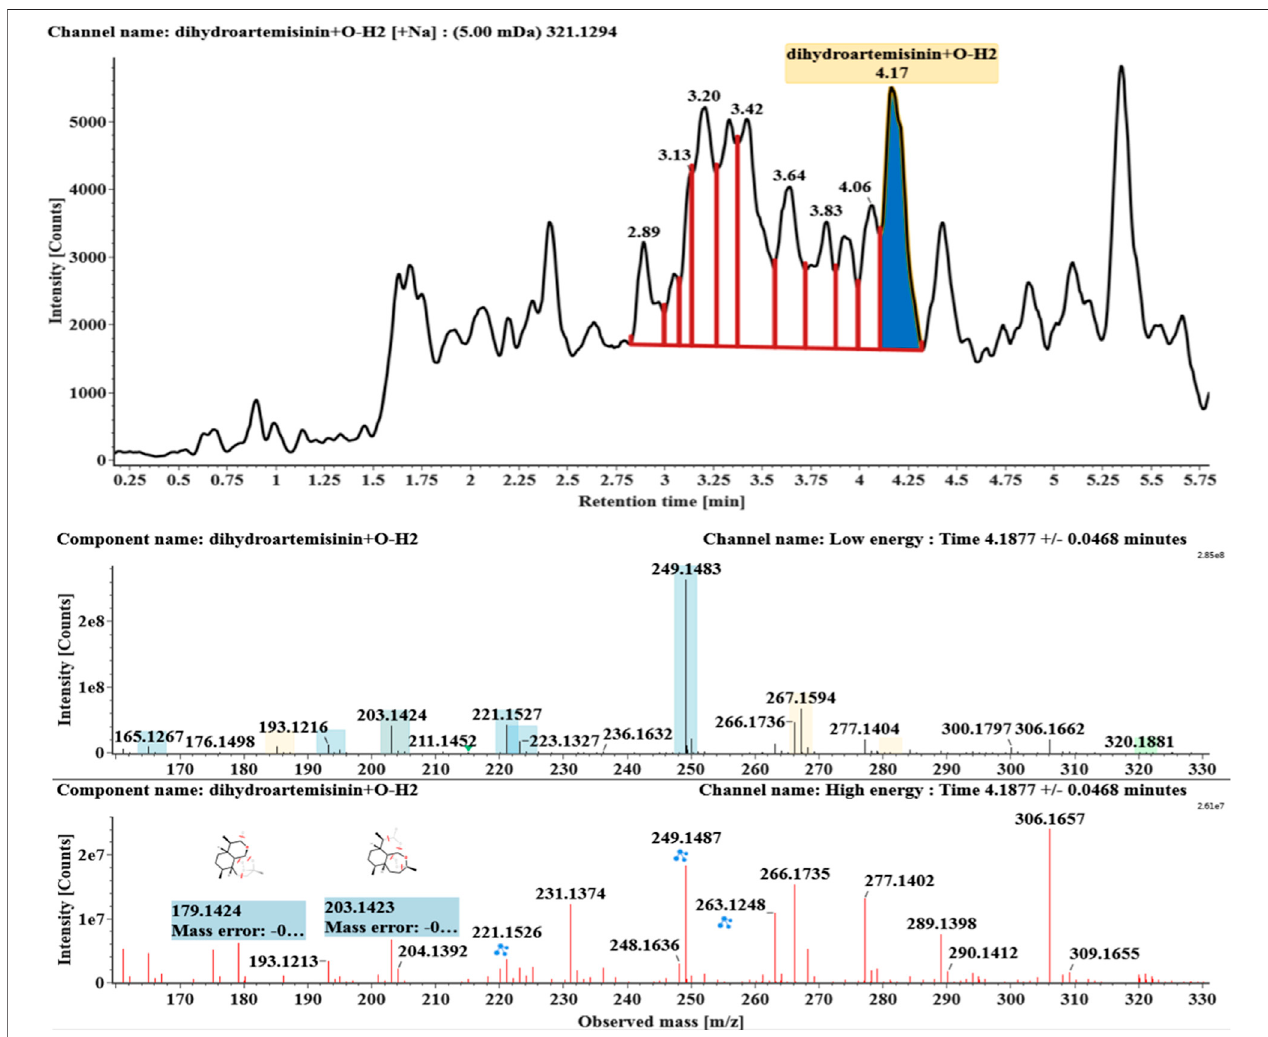
FIGURE 6 | Extracted ion chromatograms and mass spectrometry (MS E ) spectra of M5 .